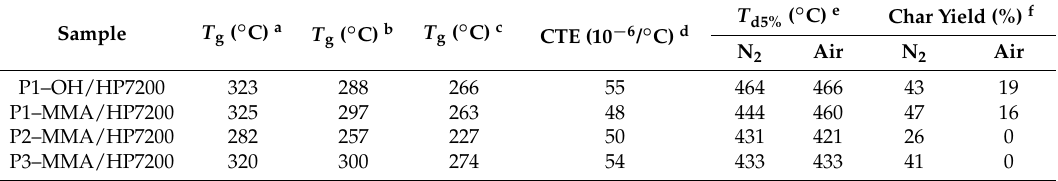
Table 2. Thermal properties of prepared polymers.